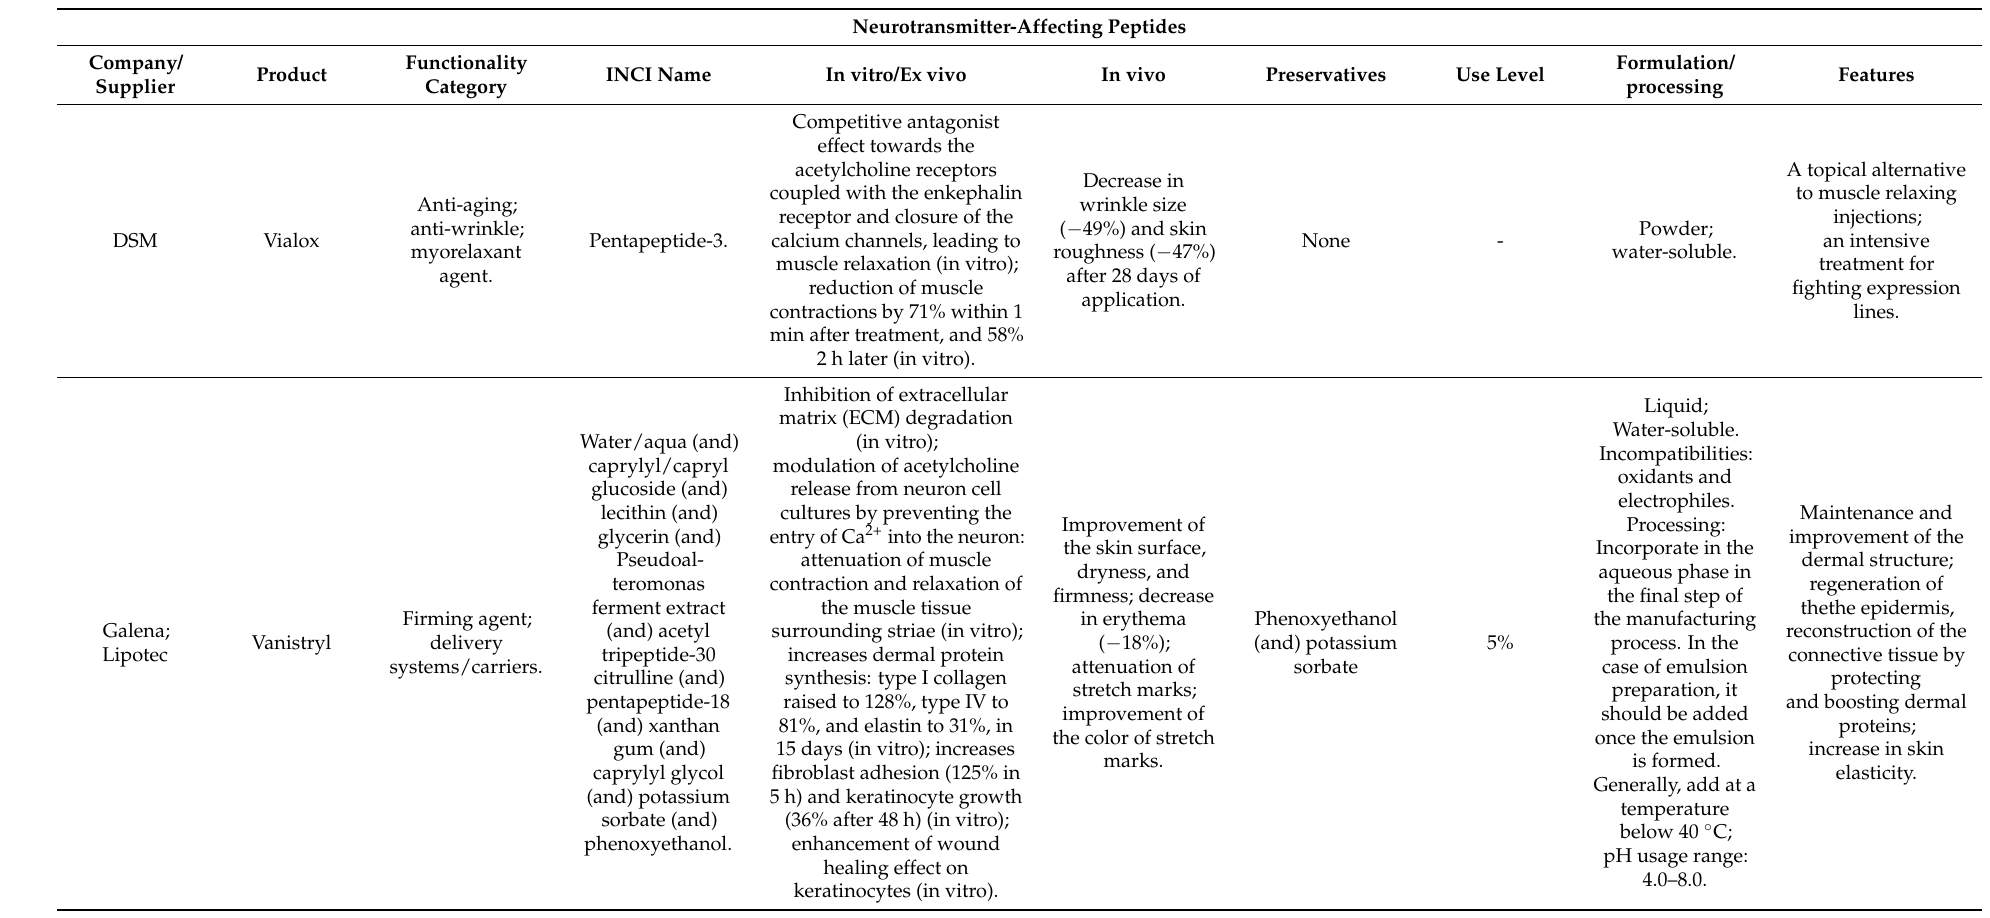
Table 2. Neurotransmitter-affecting peptides 1